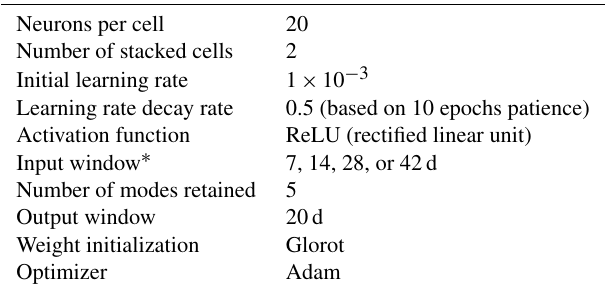
Table 1. LSTM hyperparameters used when training the low- dimensional surrogate. The quantity with an asterisk is varied, in addition to random seeds, for sensitivity analyses of the surrogate model where, in addition to the best chosen model here, several other models are trained with different weight initializations and in- put window